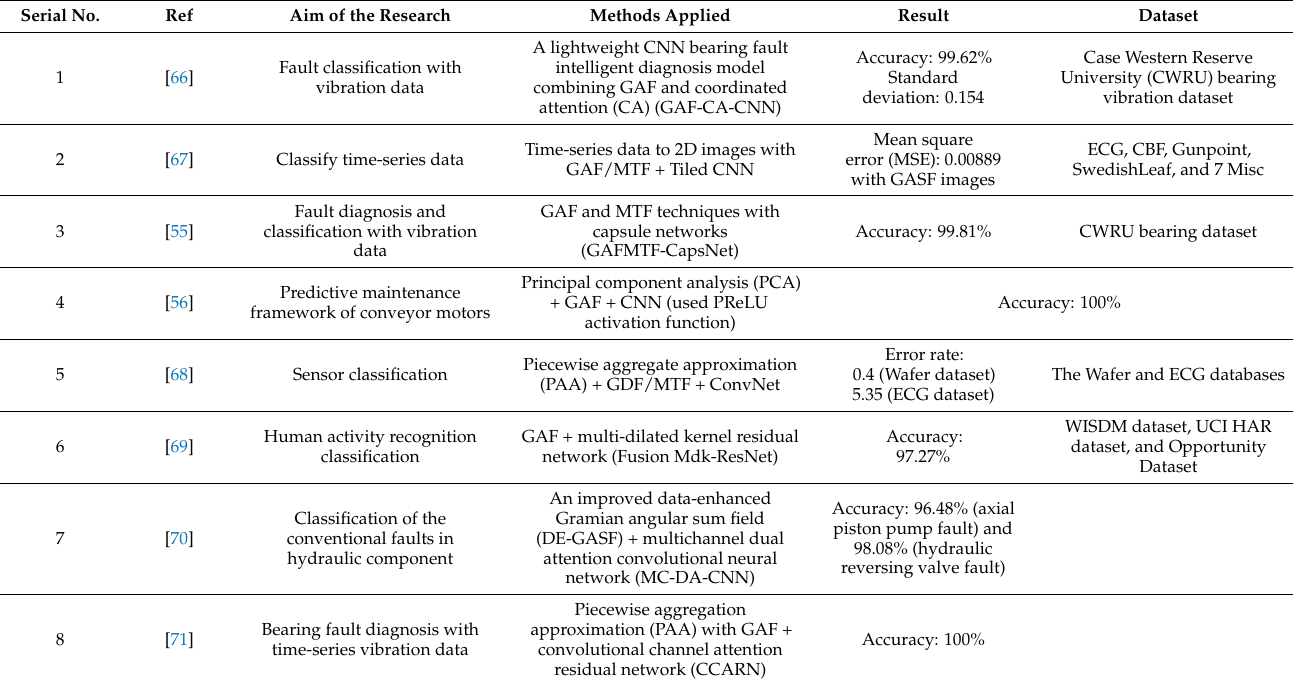
Table 9. Summary of GAF-based imaging techniques in different